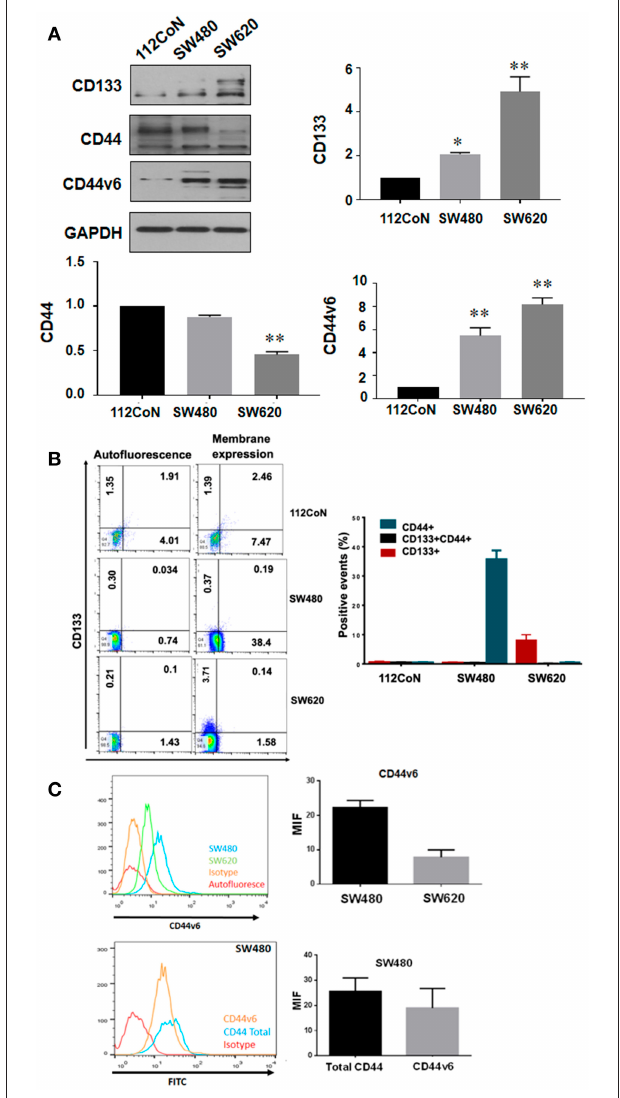
FIGURE 1 | Expression of CD133, CD44, and CD44v6 in normal and colorectal cancer cell lines. (A) Western blot showing the expression of CD133, CD44, and CD44v6 on total lysates of the cell lines. GAPDH were used as a load control. The results shown are representative of at least three independent experiments using different cell preparations. A densitometric analysis of the expression levels found for each marker is shown at the right and the data represent the means ± SEM from at least three independent assays * p = 0.01; ** p = 0.001. (B) Membrane expression of CD133 + , CD44 + , and CD133 + CD44 + subpopulations in 112CoN, SW480, and SW620 cell lines. Acquisition of 1 × 10 4 events. Anti-CD133 –PE-coupled and anti-CD44 –APC-coupled were used to stain proteins. MOFlow cytometer were used to acquired samples. (C) Membrane expression of CD44v6 in SW480 and SW620 cell lines. Acquisition of 1 × 10 4 events. CD44v6 and a secondary antibody mouse anti-CD44v6 FITC-coupled were used to stain proteins. FACScalibur cytometer were used to acquired